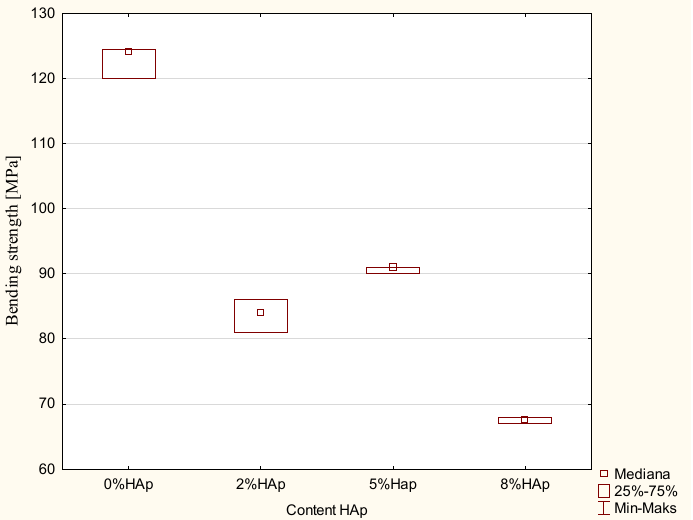
Figure 1. Statistically significant differences in bending strength among examined groups.